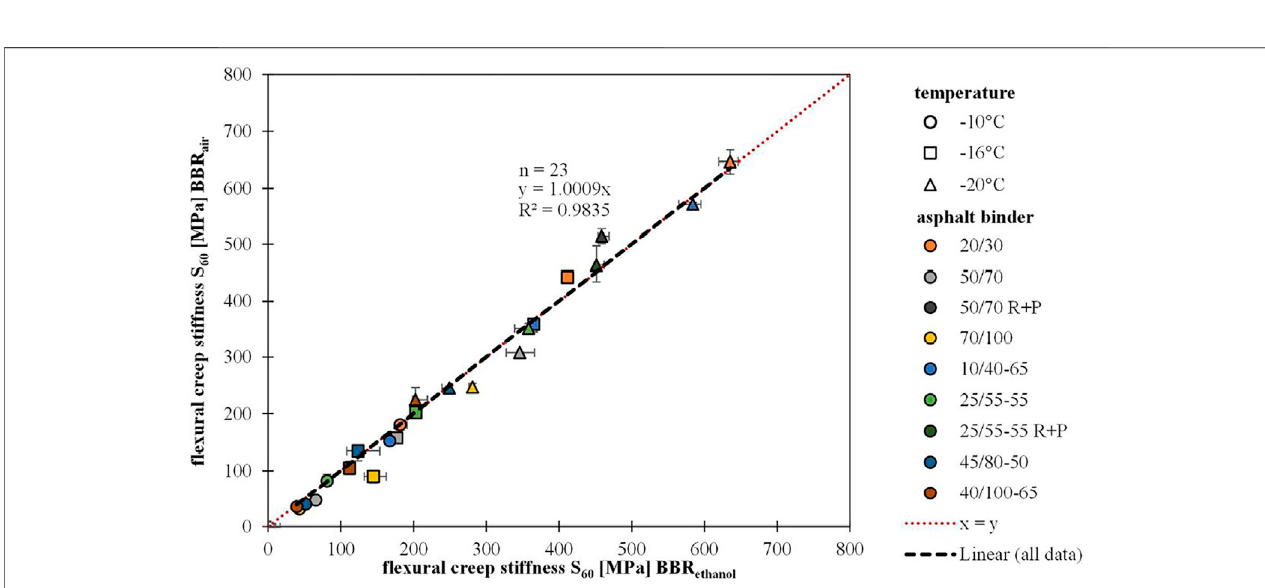
Frontiers in Materials |